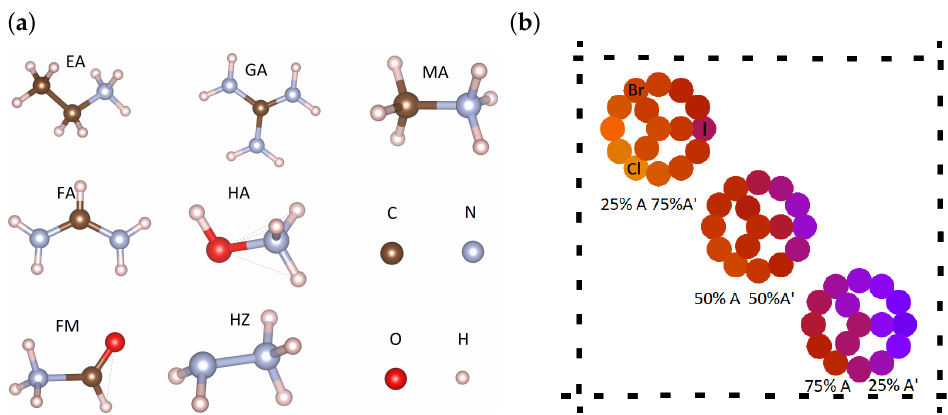
Figure 1. ( a ) Organic cations used in perovskite structures (A and A’); ( b ) The pattern of presentation in each of the figures below. We will show multiple compositions of mixed-cation and mixed- halide perovskites: three binary mixtures of cations (three composite circles, each with 16 dots, corresponding to the indicated proportions of A and A’), three binary halogen mixtures (dots on the circles) and four ternary halogen mixtures (dots within the circles). The middle dot corresponds to equal halogen proportions. The colors are set to encode the magnitude of the different quantities (measures of optical absorption and